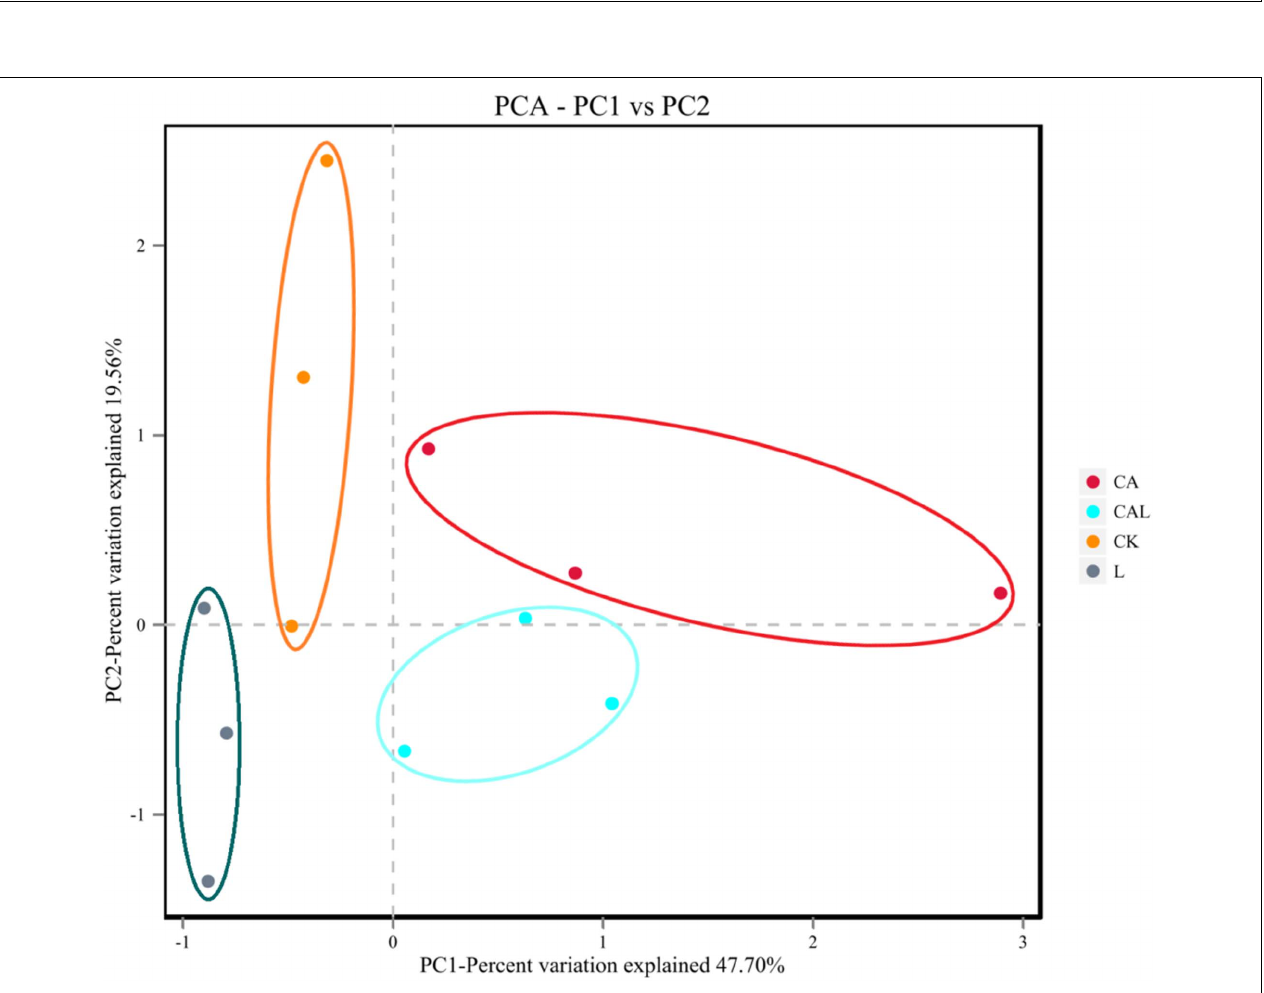
FIGURE 2 | Beta-diversity of the bacterial community of KG silage (CK, control; L, Lactobacillus plantarum ; CA, Citric acid; CAL, Citric acid + Lactobacillus plantarum ).